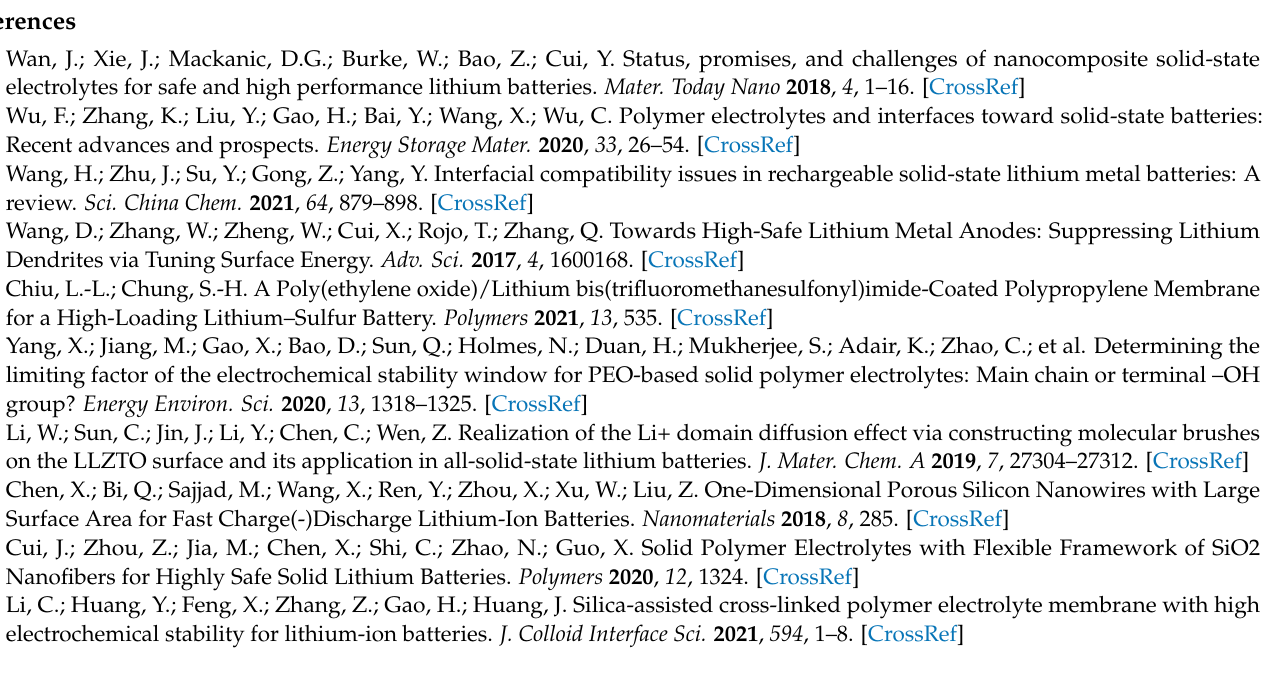
Figure S3: EIS profiles of 10% p-V-SiO 2 /PEO CPE at the range of at the range of 30–80 ◦ C. Figure S4: Cycle performance of Li|10% p-V-SiO 2 /PEO CPE|LiFP cells at 1 C at 60 ◦